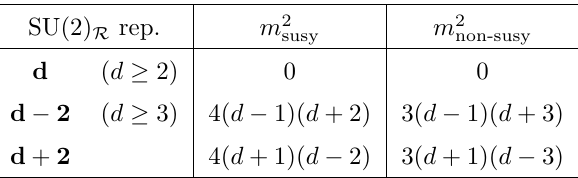
Table 1 . Masses for the supersymmetric and non-supersymmetric vacua, and their R-symmetry